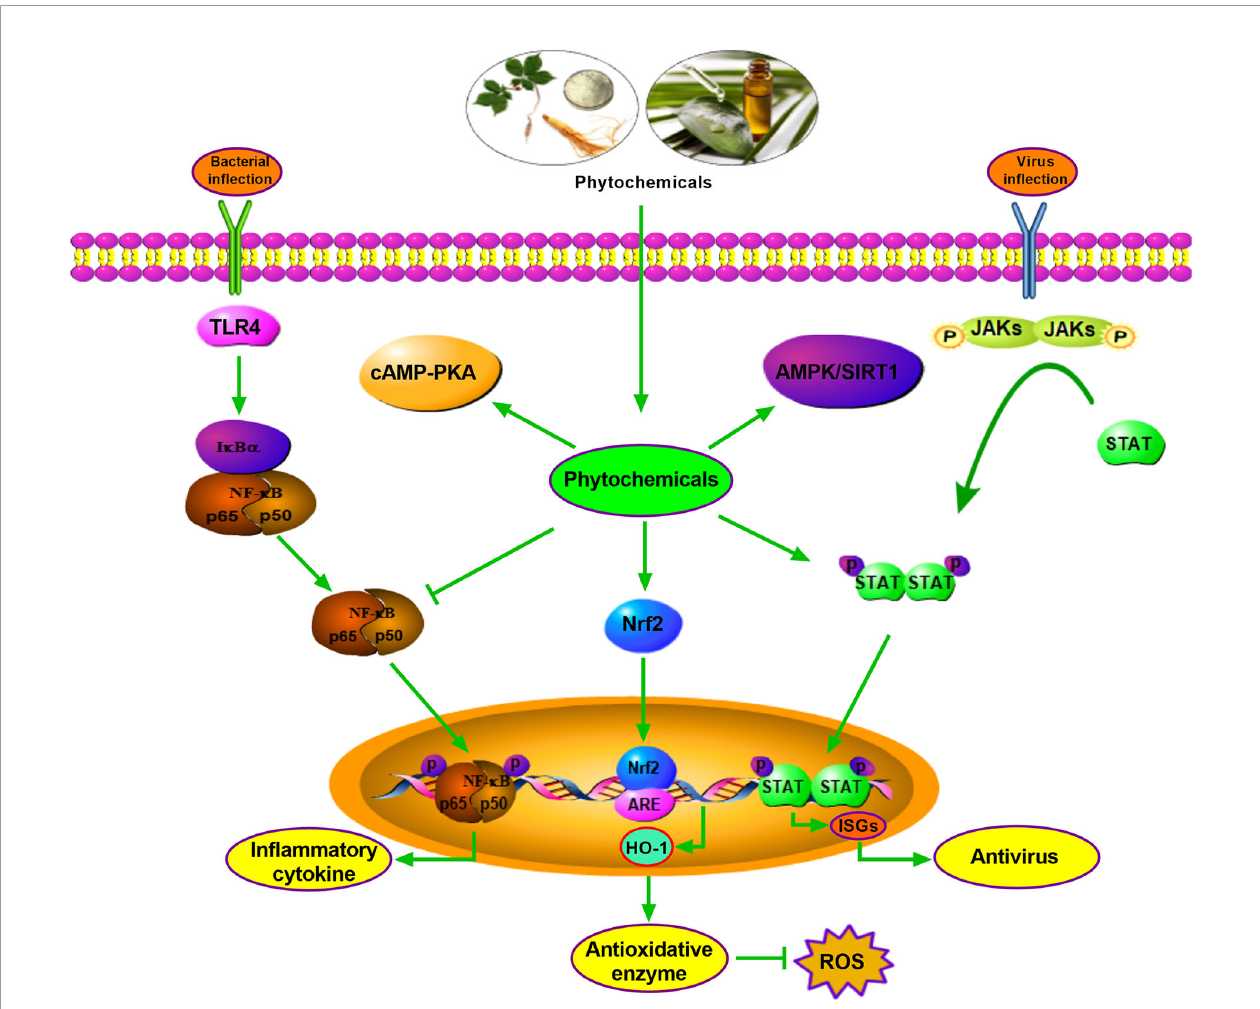
FIGURE 1 | Antimicrobial, antivirus, antioxidant mechanism of parts phytochemicals. Phytochemicals exert antimicrobial effect by inhibiting NF-kB signaling, and function as antioxidant role by activating Nrf2-HO-1 pathway. Phytochemicals show antivirus function relying on STAT pathway. Other pathways such as cAMP-PKA and AMPK/SIRT1 are also involved in antimicrobial, antivirus or antioxidant